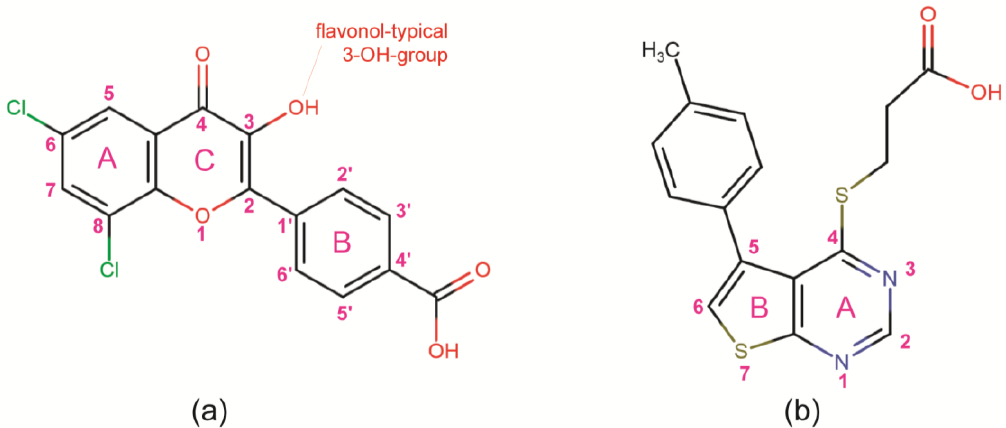
Figure 1. Structures of the ATP-competitive inhibitors FLC21 [28] ( a ); and TTP22 [29] ( b ) used for co-crystallization with human CK2α and/or CK2α′ constructs in this work. FLC26, the sister compound of FLC21 [22,28], which is used as a reference here (see Section 2.2), contains two bromo rather than chloro substituents at ring A attached to C -atoms 6 and 8.